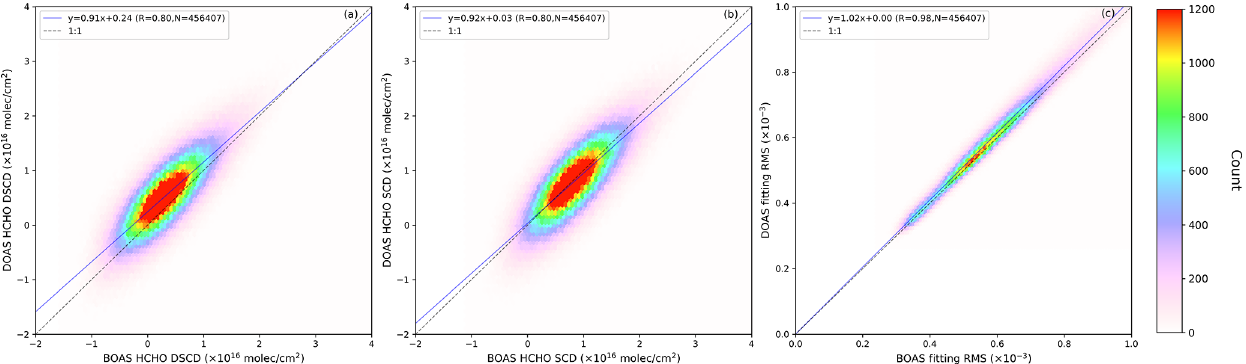
Figure 5. (a) Pixel-to-pixel comparisons of DOAS and BOAS HCHO DSCDs, (b) DOAS and BOAS HCHO SCDs and (c) DOAS and BOAS fitting rms values on 6 August 2018 in the region between 73 and 130 ◦ E and 18 and 54 ◦